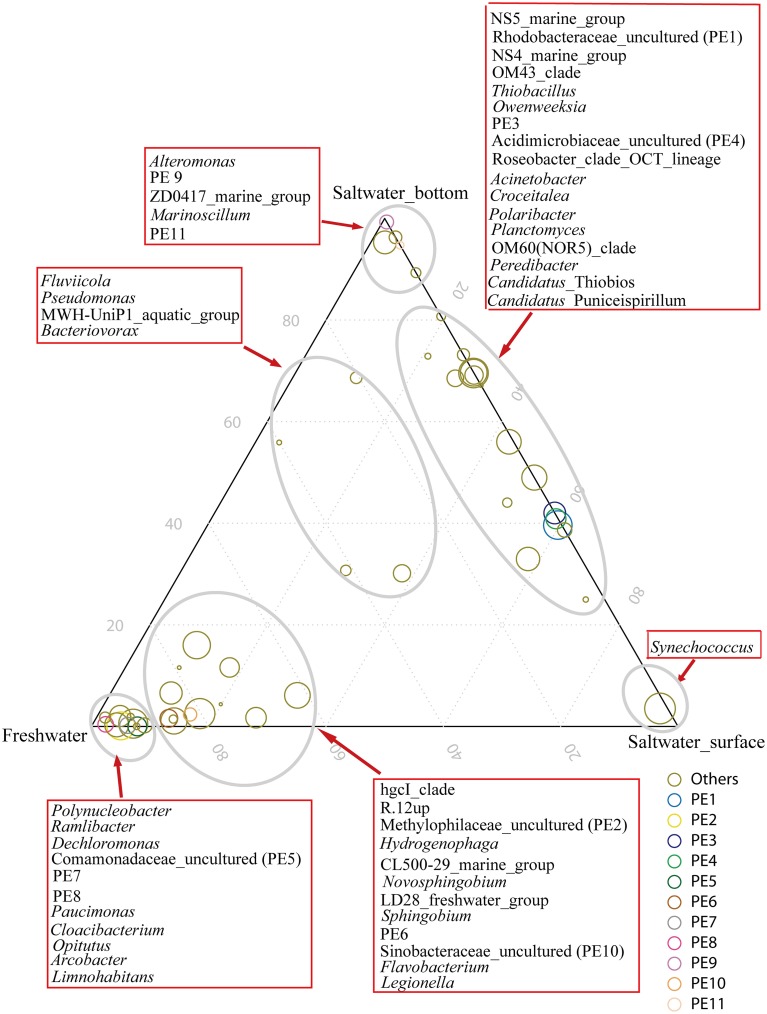
Ternary plot generated in R software showing the distribution and their relative abundances of the top 50 genera in the freshwater sites, and surface water and bottom water of the saltwater sites. The size of the symbol indicated relative abundance of each genus. Taxonomic affiliations were indicated by colors.